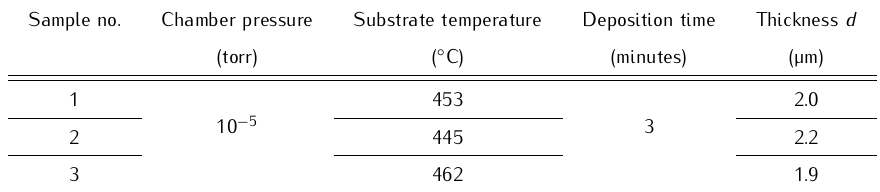
Table 1. Technological parameters of CuInSe 2 thin films Sample no.